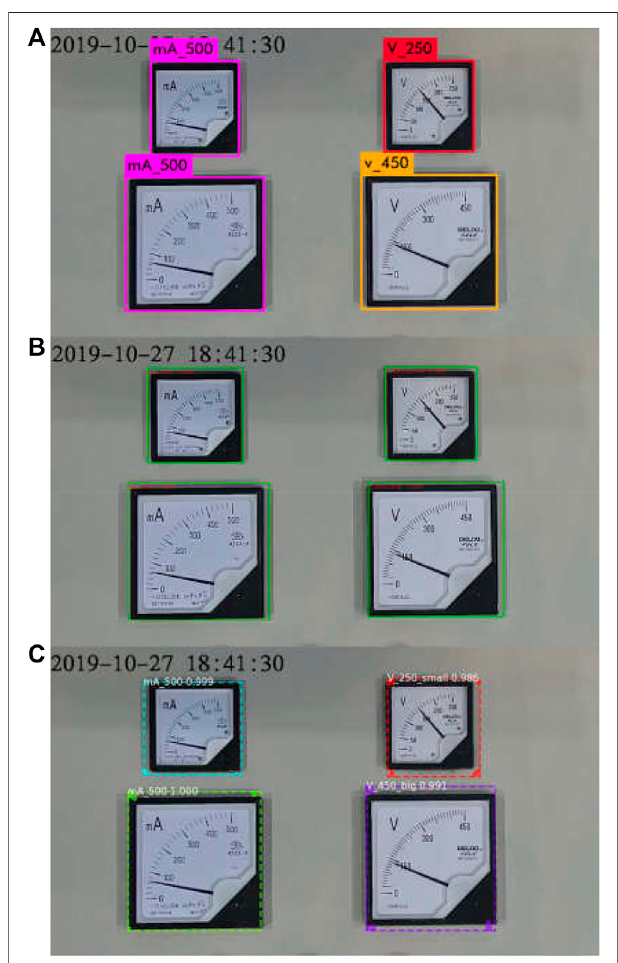
FIGURE 6 | The target region predicted results of the pointer instrument by the three algorithms. (A) The predictedresult which used the algorithms by this paper. (B) The predicted result which used Faster R-CNN algorithms. (C) The predicted result which used Mask RCNN algorithms.